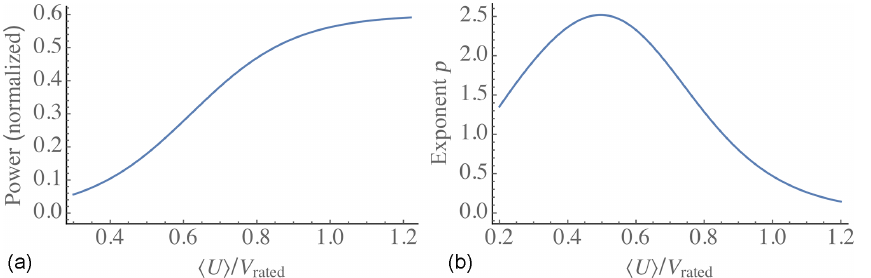
Figure A4. (a) Normalized AEP vs. mean wind relative to rated wind speed. (b) AEP effective power-law exponent vs. mean wind over rated speed, obtained via integrable power-law form (Eq. B1) and subsequent dimensionless AEP (Eq. B3) for Weibull-distributed wind with k =